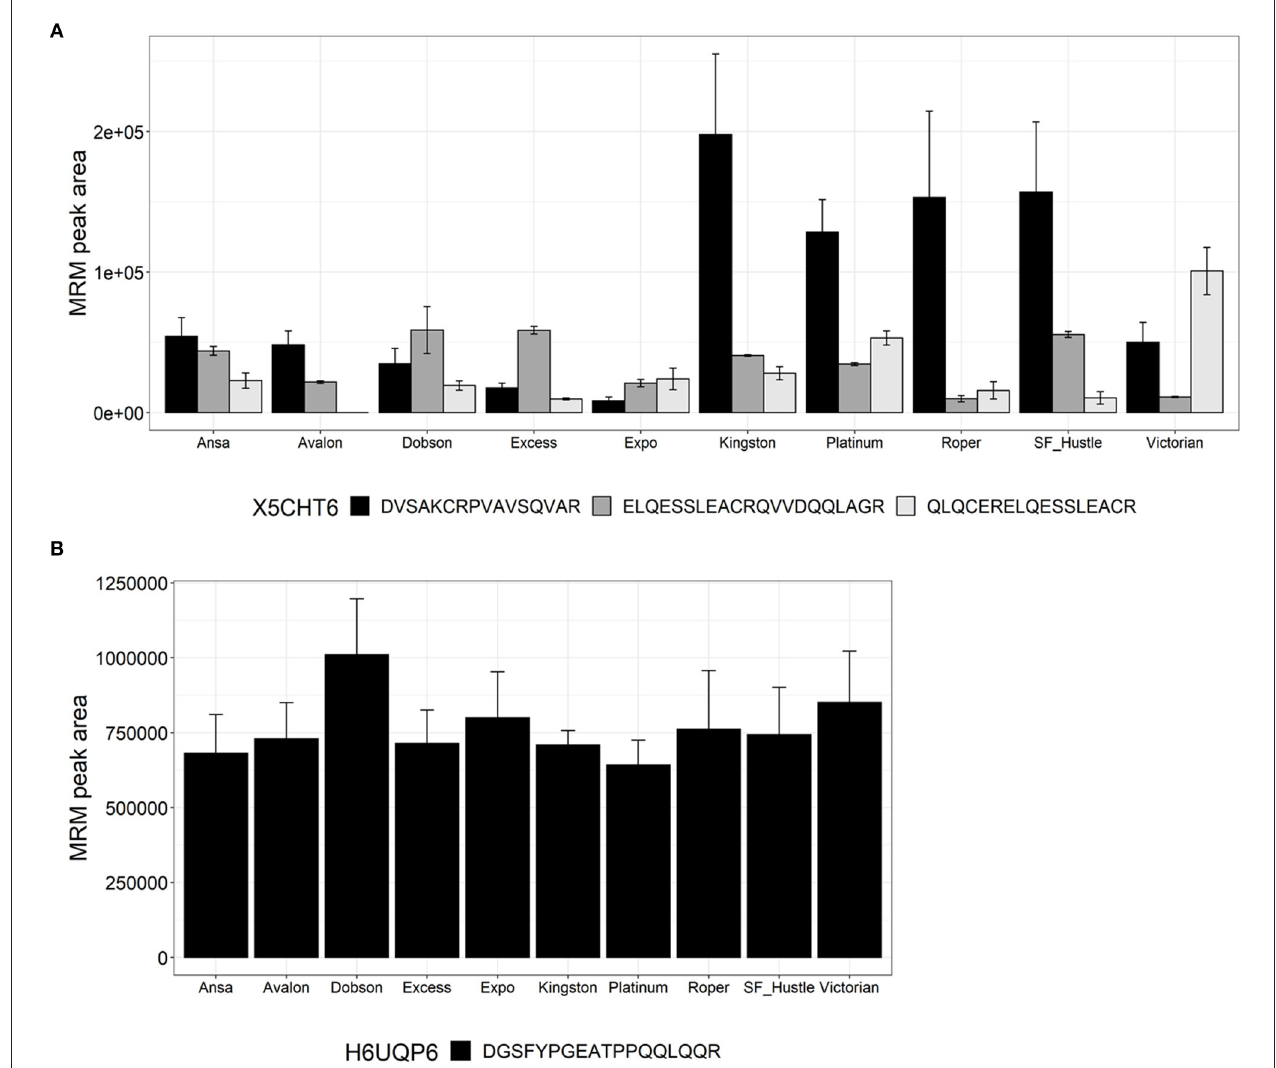
FIGURE 4 | Relative quantitation of glutenin peptides across the 10 varieties of L. perenne from proteins of the family PF03157. Data are presented as the mean ± SD ( n = 3) with one to three peptides from each protein. (A) HMW-glutenin (X5CHT6); and (B) HMW-glutenin